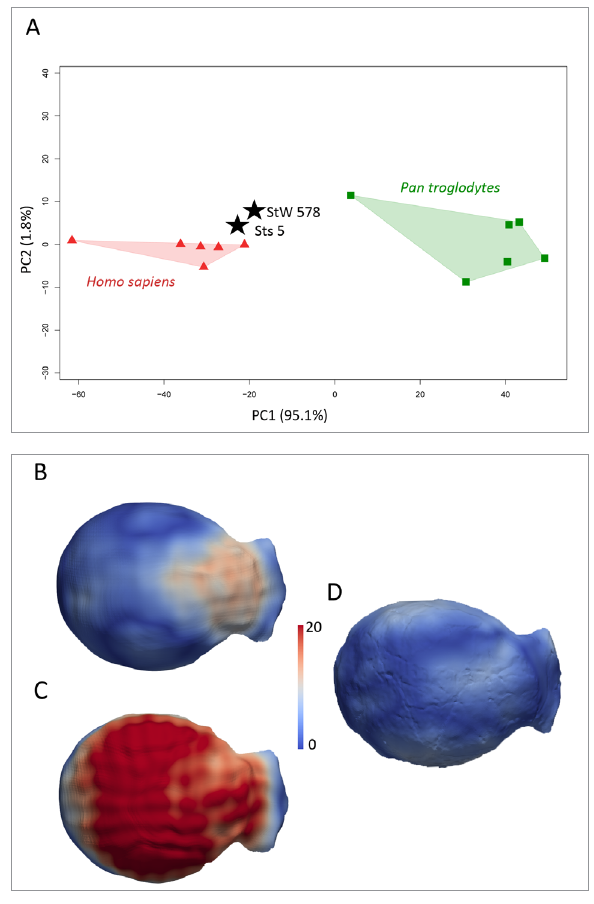
Figure 3: Principal component (PC) analysis of the deformation-based shape comparisons of the StW 578 and Sts 5 calottes and of the extant human and chimpanzee calottes (A). Comparative maps of morphological deformations from the taxon-specific mean shapes computed for extant humans (B) and extant chimpanzees (C) to StW 578 and from Sts 5 to StW 578 (D) in superior view. The colour bar represents the number of